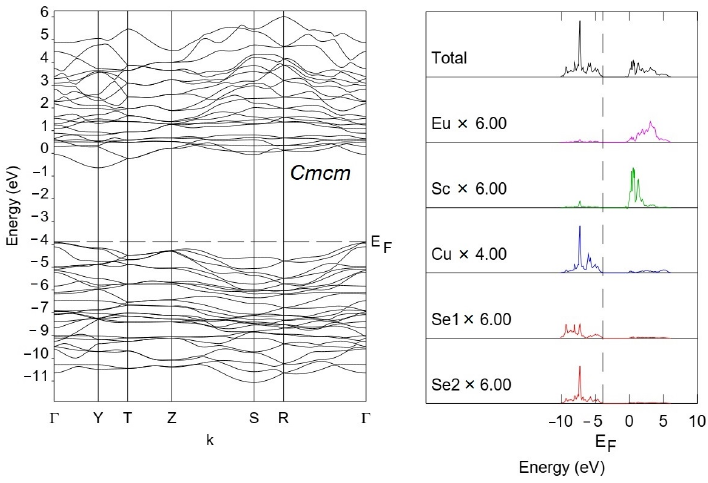
Figure 5. Band structure and electronic density of states for EuScCuSe 3 .